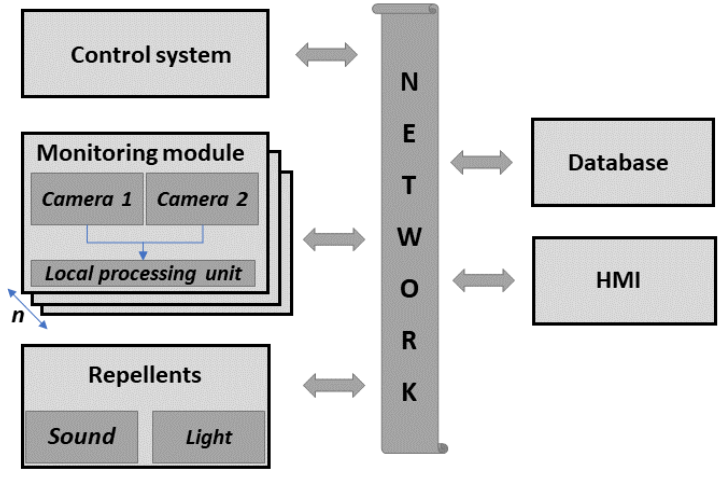
Figure 1. Block diagram illustrating the system